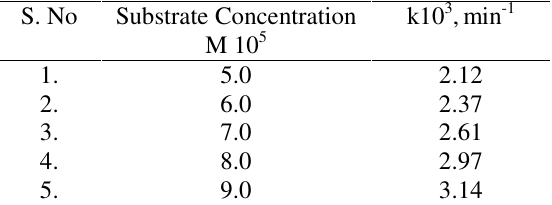
Table 2. Effect of 2,4-dinitrophenol concentration.